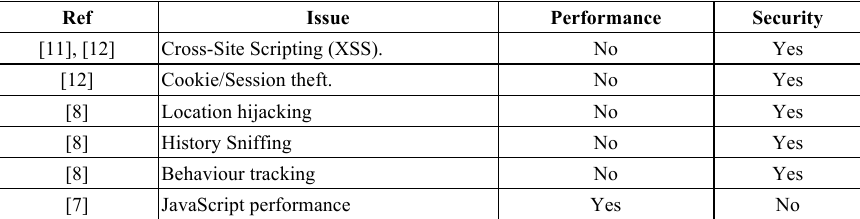
Table 2. Open issues for Mobile Web Browser